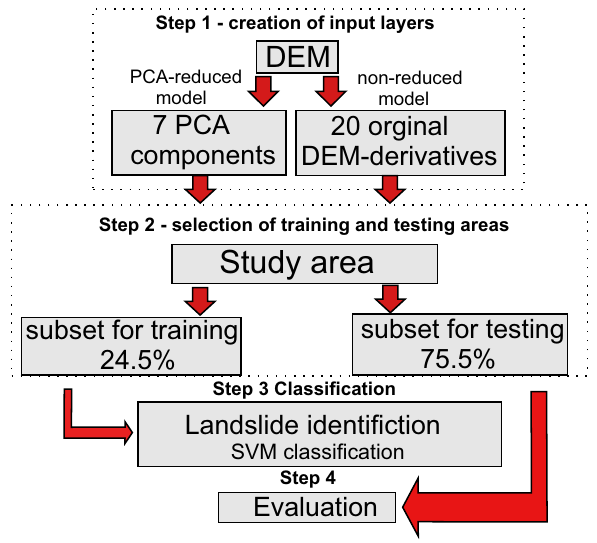
Figure 3: Methodology flowchart